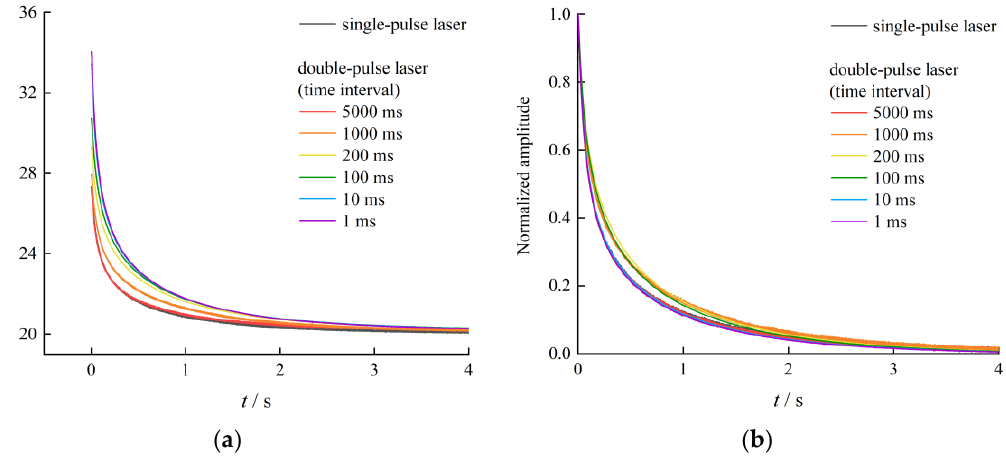
Figure 6. The comparison of output response curves under single and double pulse laser: ( a ) Com- parison of falling edges of output response curves; ( b ) Comparison of the falling edge of the output response curve after amplitude normalization.